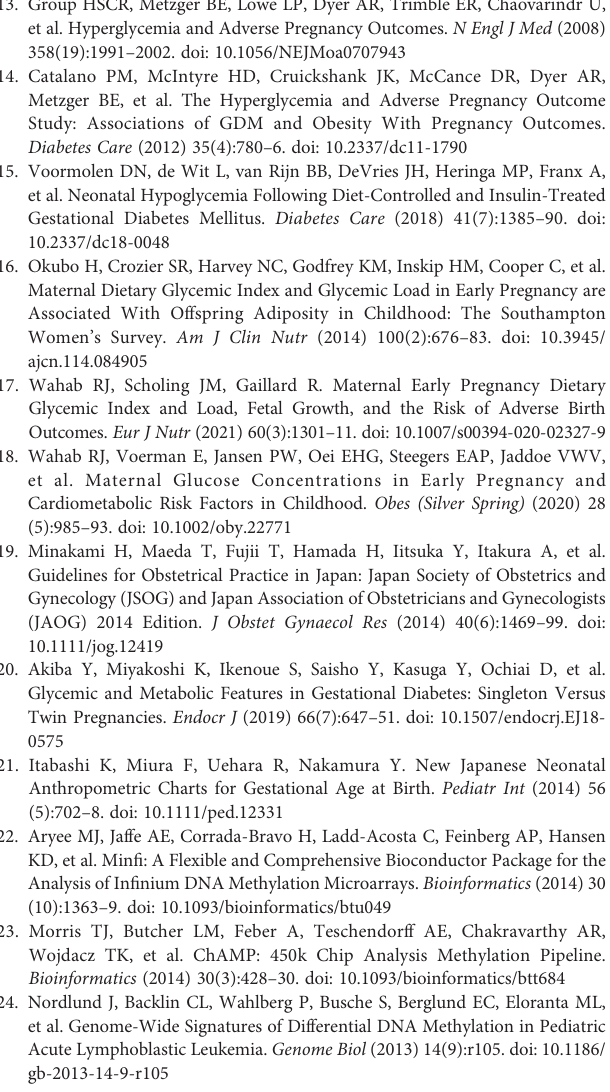
each covariate confounder (neonatal sex, gestational age, and C-section) individually. The corrected in fl ation factor for each analysis is shown as a QQ plot. Neonatal sex was a major confounder of the association between DNA methylation at CpG sites in chr8:144371446 – 144372076 (hg19) and PG at 1 h after birth. Supplementary Figure 6 | The association between DNA methylation in 12 CpG sites proximal to the TSS of the ZNF696 isoform (ENST00000330143) and PG at 1 h after birth. Associations are shown according to neonatal sex. Supplementary Figure 7 | Reference data for TF ChIP-seq peaks from ENCODE3 data. Forty-six TFs bind the TSS of the ZNF696 isoform, whereas only ELF1 and RUNX3 were con fi rmed to bind the alternative TSS in the GM12878 cell line according to ENCODE3 data. Supplementary Figure 8 | Methylation values distribution at the 12 CpG sites in GDM and NGT were shown in box plot by neonatal sex. The 10 CpG sites whose methylation showed positive association with neonatal PG at 1 h after birth were indicated in upper panels above a dash line. The 2 CpG sites which showed negative association arrayed below a dashed line. Signi fi cant methylation value difference between GDM and NGT were analyzed by t-test (* p <